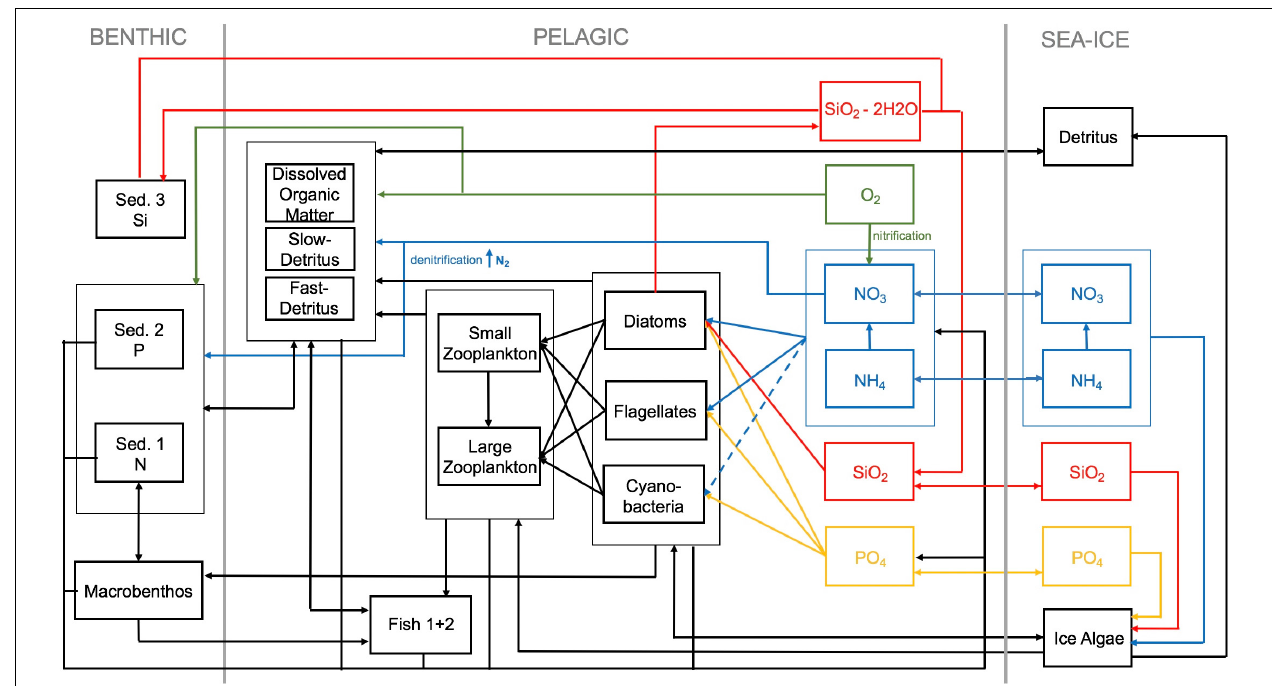
FIGURE 1 | Schematic diagram of the coupled sea-ice ocean model ECOSMO-E2E. The three system (benthic, pelagic, and sympagic) are included. Sed. 1, nitrate/carbon sediment pool; Sed. 2, phosphate sediment pool; Sed. 3, silicate sediment pool.